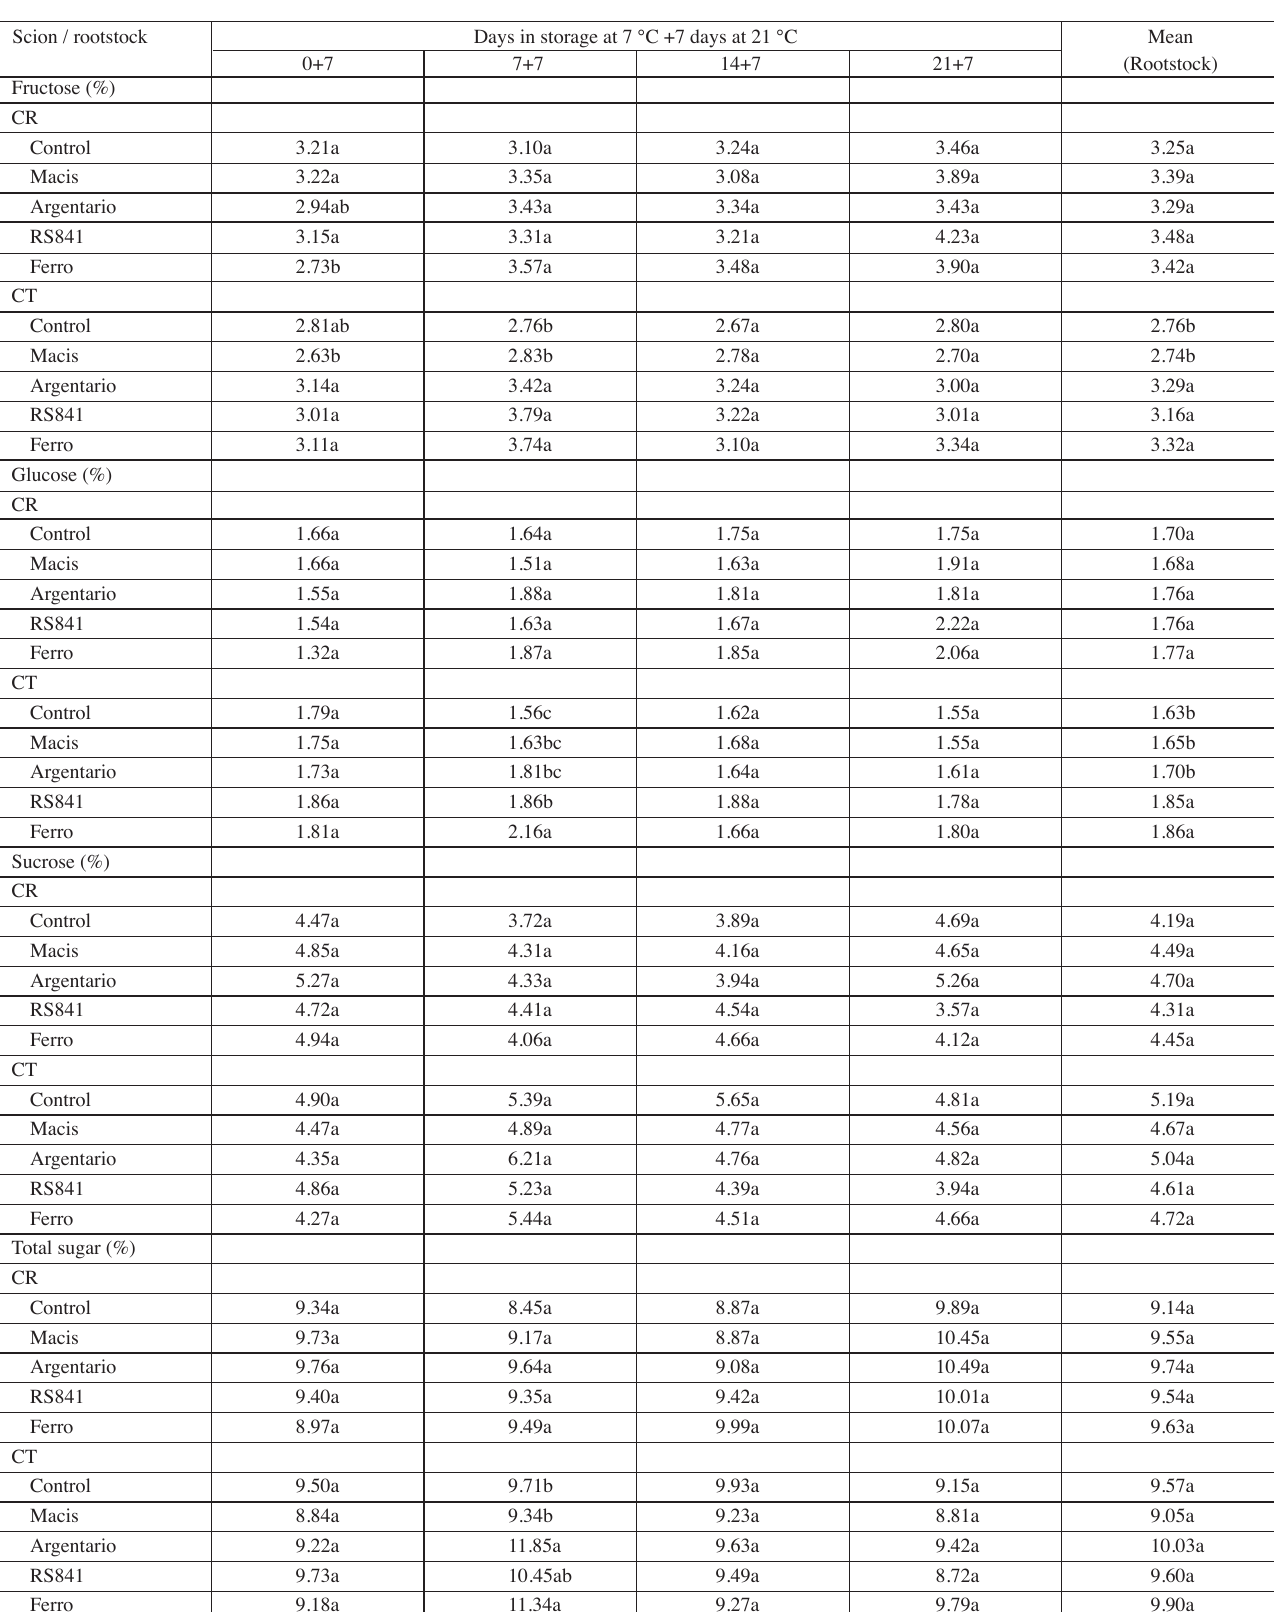
Tab. 4: Effects of rootstocks on sugar contents of ‘Crisby’ (CR) and ‘Crimson Tide’ (CT) watermelon fruits after shelf life period for 7 days at 21 °C following storage at 7 °C Scion /